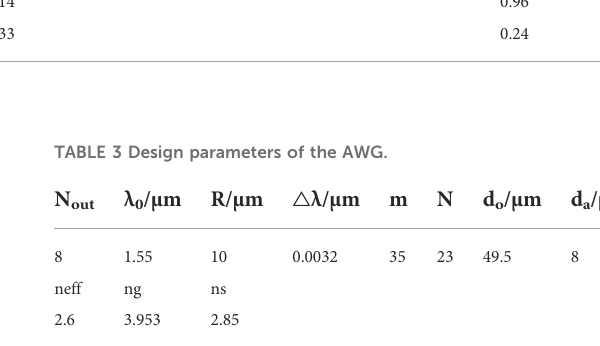
FIGURE 4 Optical micrographs of the fabricated Low-crosstalk AWG.